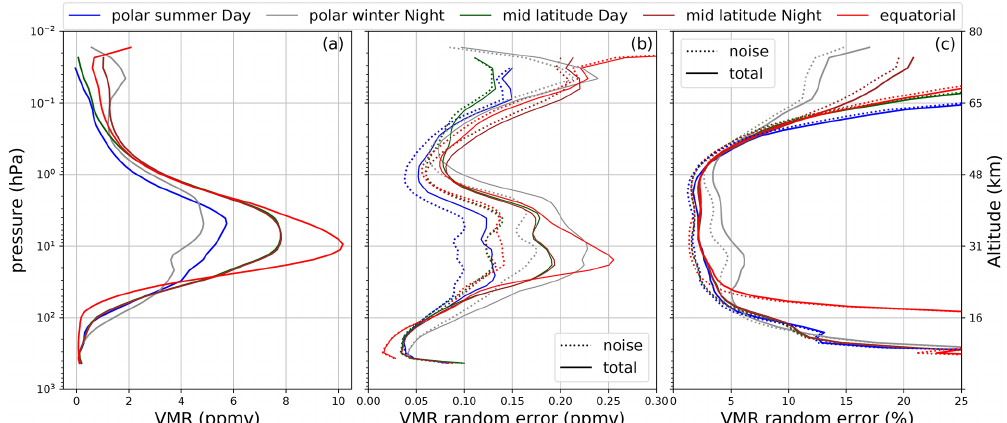
Figure 4. Ozone VMR for several conditions (a) , absolute (b) , and relative (c) random error for the optimised resolution (OR) nominal mode averaged over 2010. The dotted lines represent the average noise error; the solid lines represent the total random error, coming from the quadratic summation of the noise error and the p,T propagation